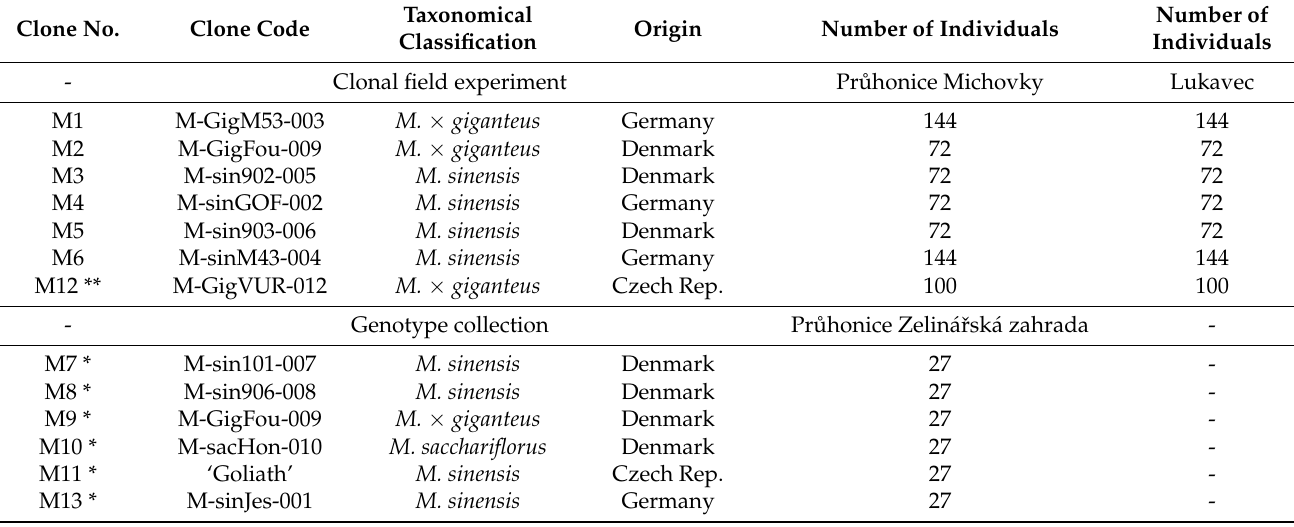
Table 3. Assortment of Miscanthus clones included in the